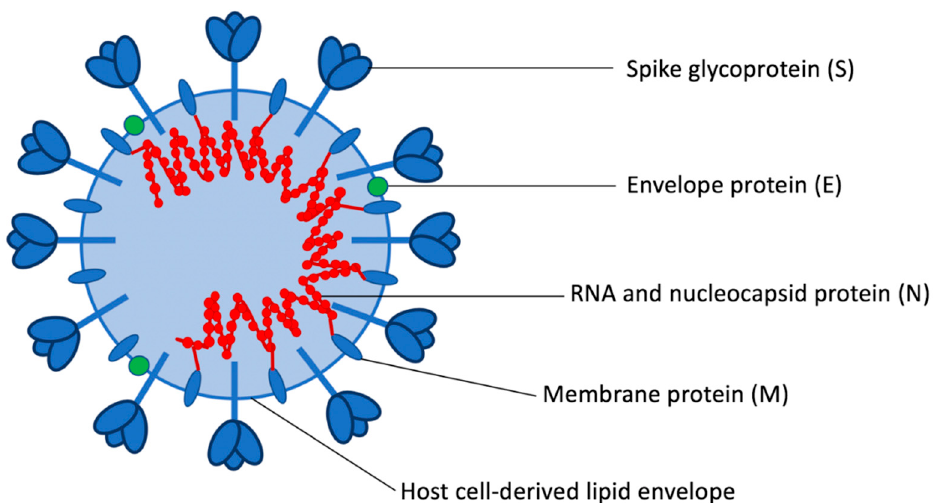
Figure 2. Coronavirus structural proteins.